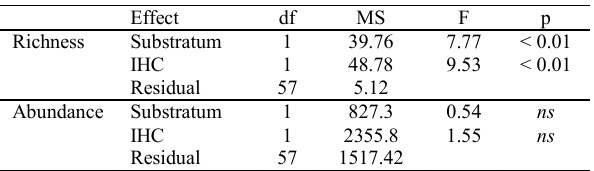
Table 7. Results of ANCOVAs testing the influence of substratum type on fish richness and abundance using the IHC as a covariate. ns :